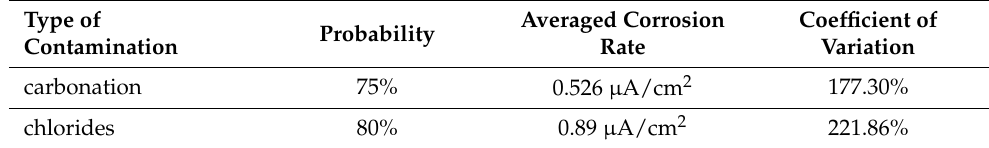
Figure 11. Proposed general statistical distributions of corrosion rate values in corroding structures. Table 2. Characteristics of the statistical distribution of averaged corrosion rate values and their coefficient of variation in real